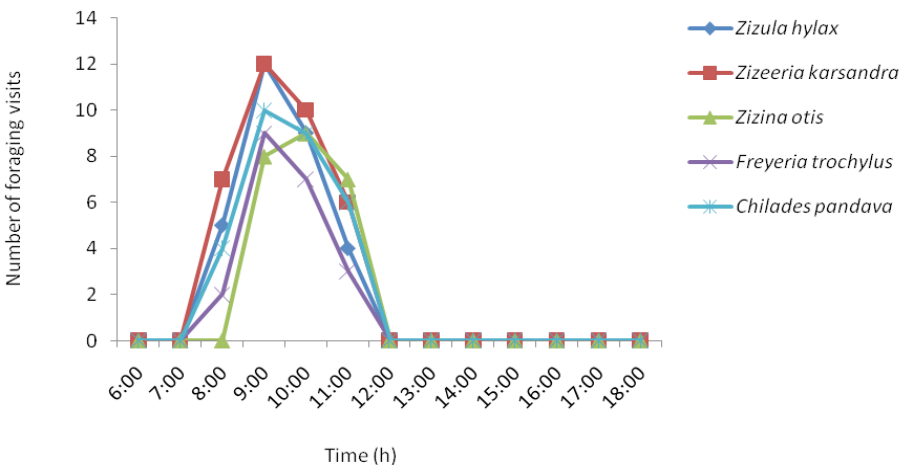
Figure 2. Hourly foraging activity of lycaenid butterflies on Mollugo nudicaulis